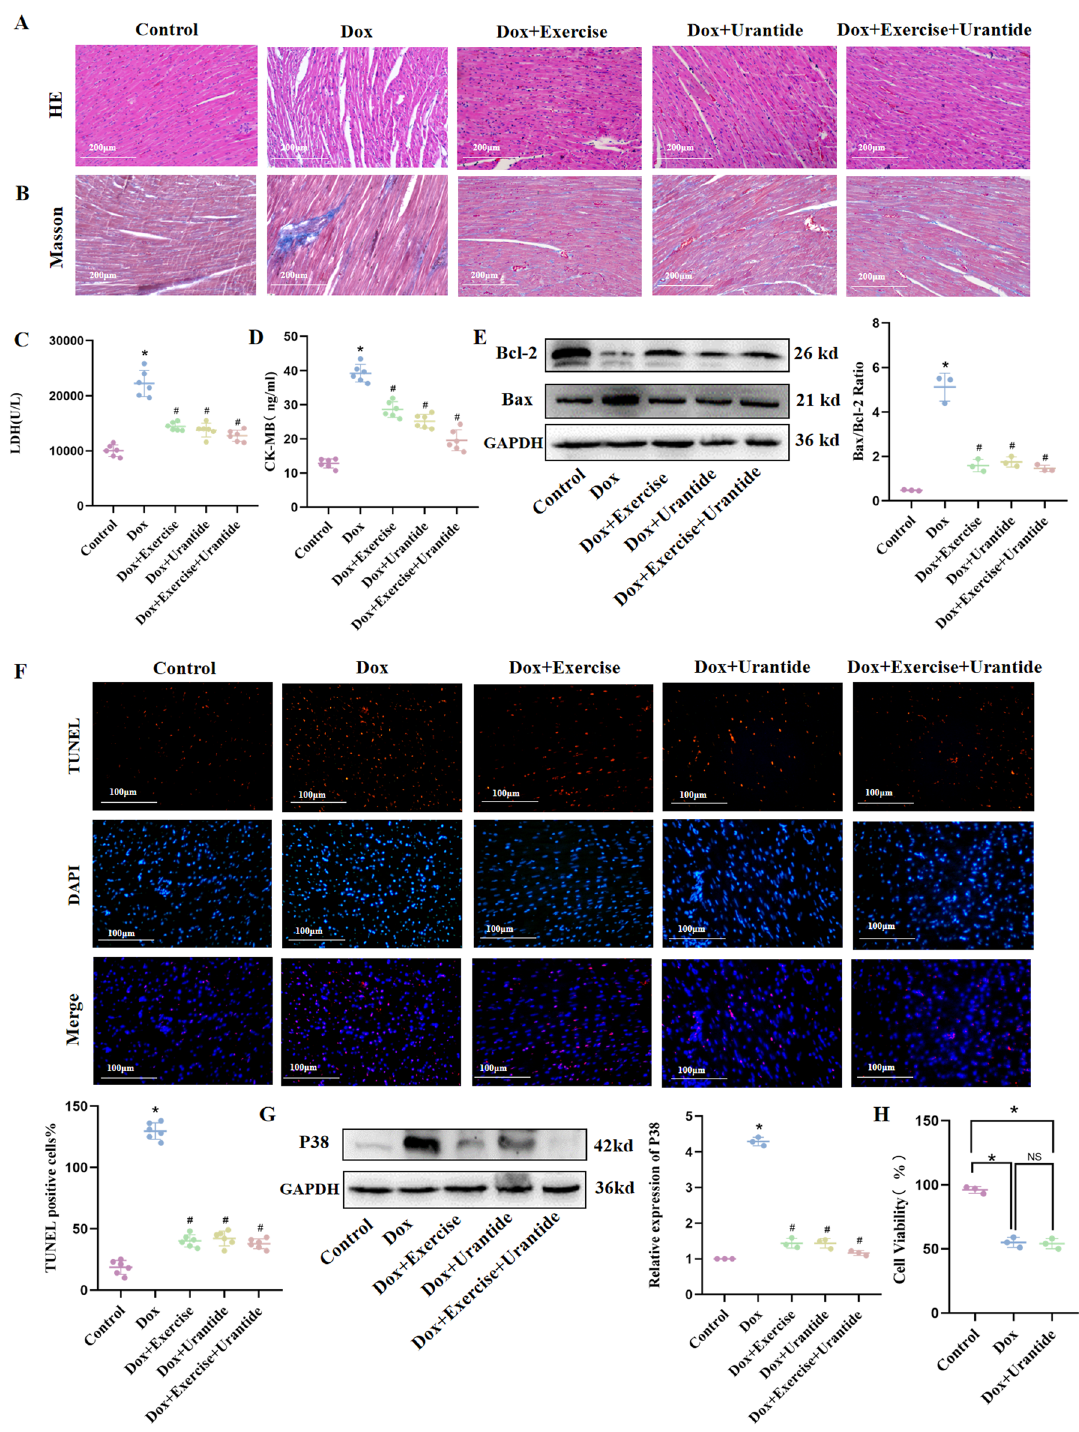
Figure 9. Urantide and (or) exercise alleviate DOX ‐ induced cardiac damage and apoptosis. ( A ) Myocardial fibers were arranged more neatly in the three treatment groups in HE staining. ( B ) Masson staining showed that the collagen content in the Urantide and (or) exercise group were significantly lower. Enzyme ‐ linked immunosorbent assay was used on serum from rats to determine the expression of LDH ( C ) and CK-MB ( D ). ( E ) DOX increased the Bax/Bcl-2 ratio, which was decreased by Urantide and (or) exercise treatments. ( F ) TUNEL-positive cells in the treatment group was significantly lower than in the DOX group. ( G ) The expression level of the p38 MAPK pathway was significantly downregulated by Urantide and (or) exercise. ( H ) The CCK8 was performed in breast cancer cells in vitro. *P < 0.05, vs. the control; # P < 0.05 vs. the DOX. NS P > 0.05 vs. the